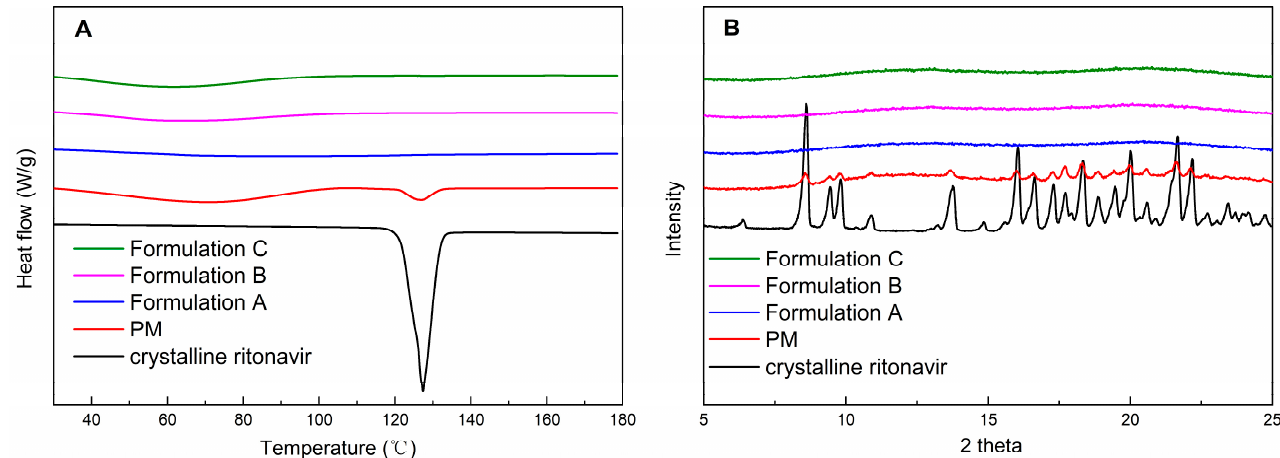
Figure 2. The DSC ( A ) and PXRD ( B ) of crystalline ritonavir, physical mixtures of ri- tonavir/PVPVA/Span 20 (PM), and milled